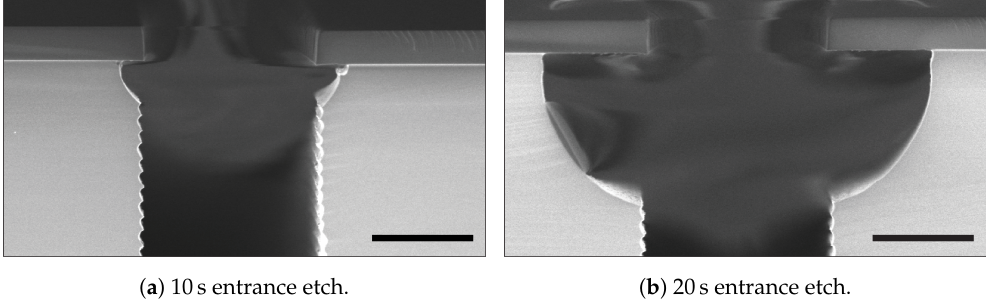
Figure 11. SEM images of the trench entrance etched with ( a ) 10s of entrance etching and ( b ) 20s of entrance etching. For both samples, the FC from the hard mask RIE was stripped prior to the trench etching. The neck was completely removed. However, rather large cavities were created. The scale bars in ( a , b ) are